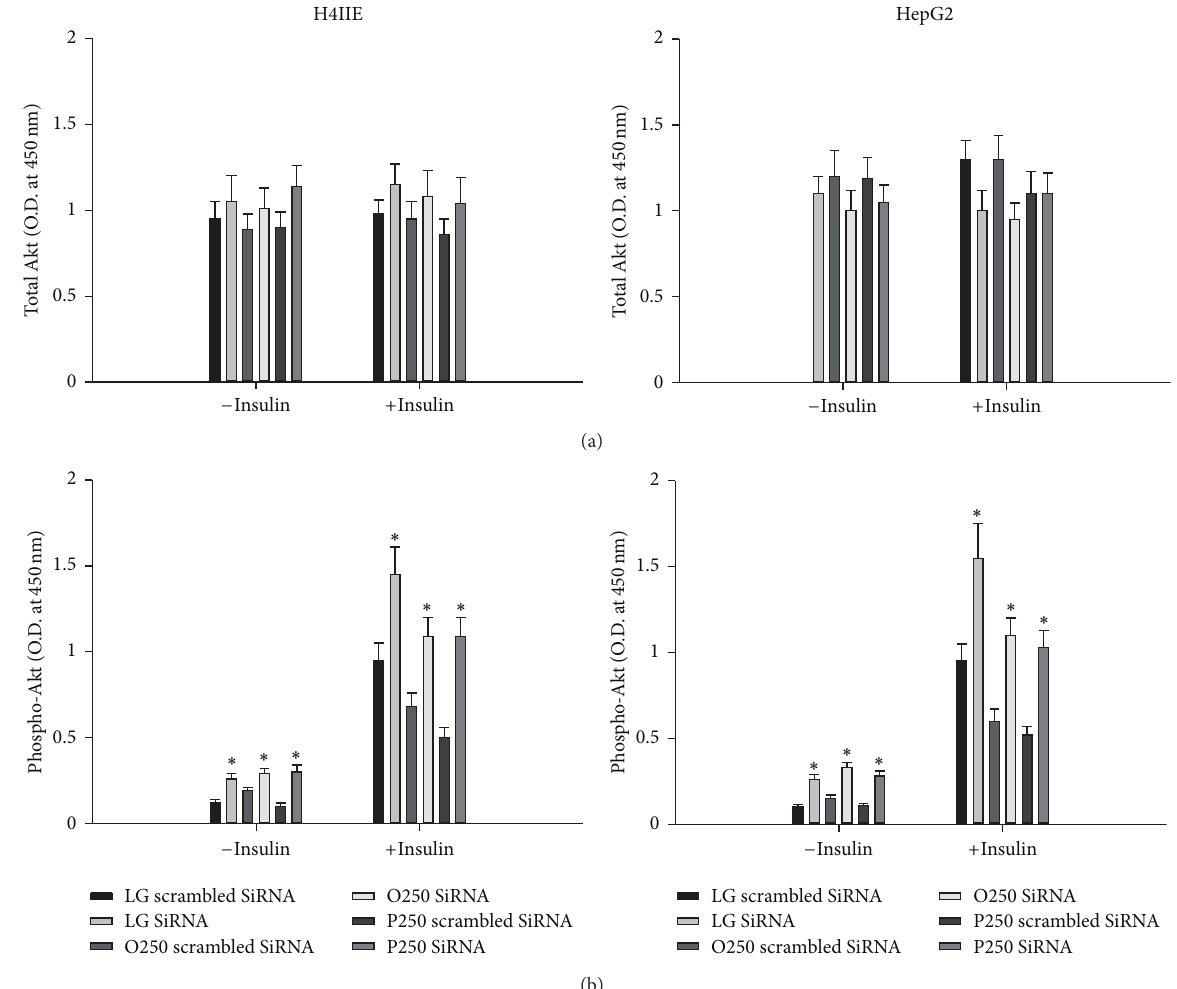
Figure 4: Effects of PTEN knockdown on phosphorylation of Akt in liver cells. Total Akt (a) and phosphorylated Akt (b)) in H4IIE (left column) and HepG2 (right column) liver cells following 16h of incubations with control media (LG) or fatty acids (oleate (O) or palmitate (P)) at 250 𝜇 M. Following incubations, cells were either treated (+ insulin) or not treated ( − insulin) with 1nM insulin for 30 minutes ( 𝑛 = 6 ). ∗ : significantly ( 𝑃 < 0.05 ) different from corresponding scrambled SiRNA